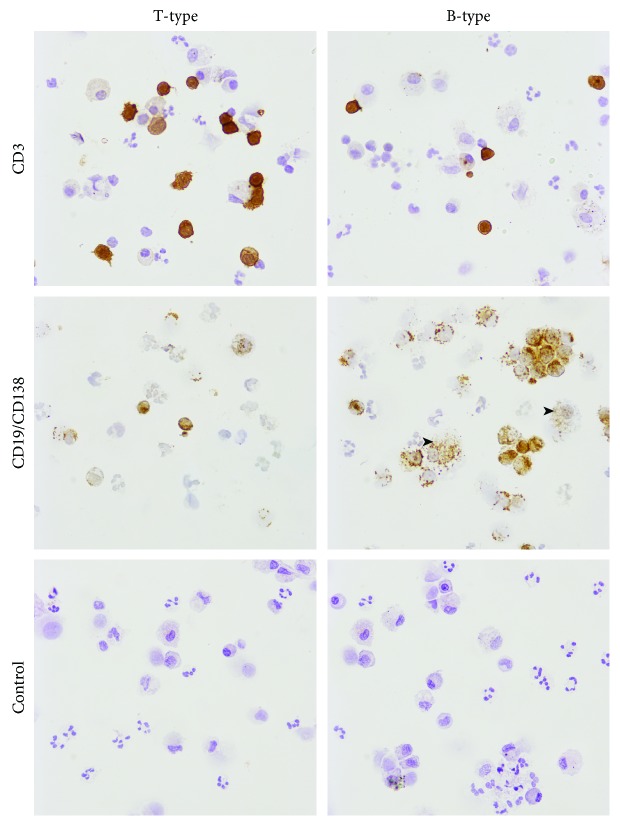
Immunocytochemical presentation of T-type and B-type periapical lesions. Cytospins of periapical lesion (PL) cells were stained with an anti-CD3 (marker of T cells) or a combination of anti-CD19 (B cell marker) and anti-CD138 (marker of plasma cells), as described in “Materials and Methods.” A representative sample of T-type PL (predominance of T cells over B cells/plasma cells) or a sample of B-type PL (predominance of B cells/plasma cells) over T cells is presented. Macrophages, which are positively stained with CD138 (intracytoplasmic granular staining), are excluded from the analysis, based on morphological criteria. Some of them are marked by arrows. Controls are stained by an irrelevant (anti-rat CD4) monoclonal antibody, nonreactive with human tissues. Magnifications: ×200.